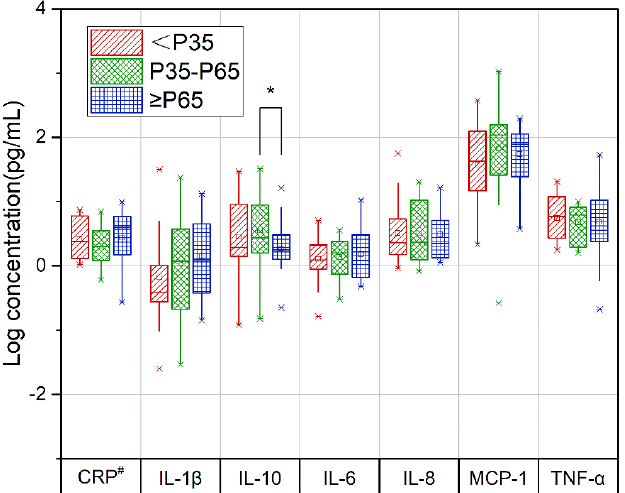
Figure 3. Relationship between the change in repeated measurements of the DII and cytokine levels in pregnant women during the second and third trimesters of pregnancy. Red slashes represent the <P35 group, green diamonds represent the P35-P65 group, and blue squares represent the ≥ P65 group. CRP, C − reactive protein; IL − 1 β , interleukin 1 β ; IL − 6, interleukin 6; IL − 8, interleukin 8; IL − 10, interleukin 10; MCP − 1, monocyte chemoattractant protein − 1; T2, second trimester; T3, third trimester; TNF − α , serum tumor necrosis factor − α . Concentrations of cytokines in the second trimester and energy intake in the second and third trimesters were treated as covariates. Data from the 74 pregnant women who completed the second- and third-trimester follow-ups. * p value for the comparison between P35-P65 and ≥ P65 groups, α = 0.017. # CRP level is the logarithm of the cytokine level